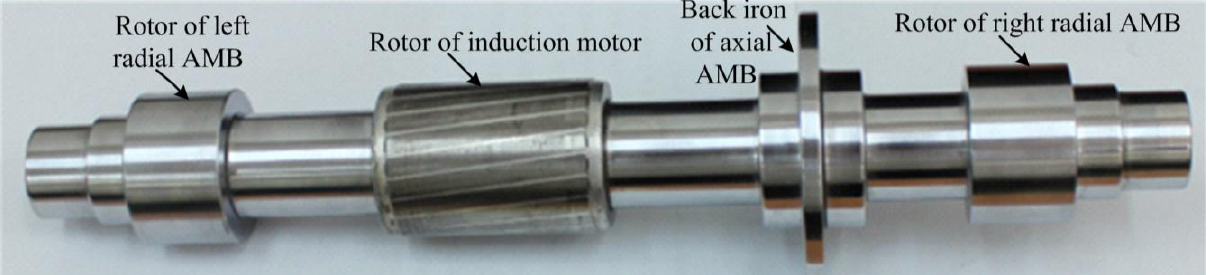
Figure 2. Rotor inside AMB.